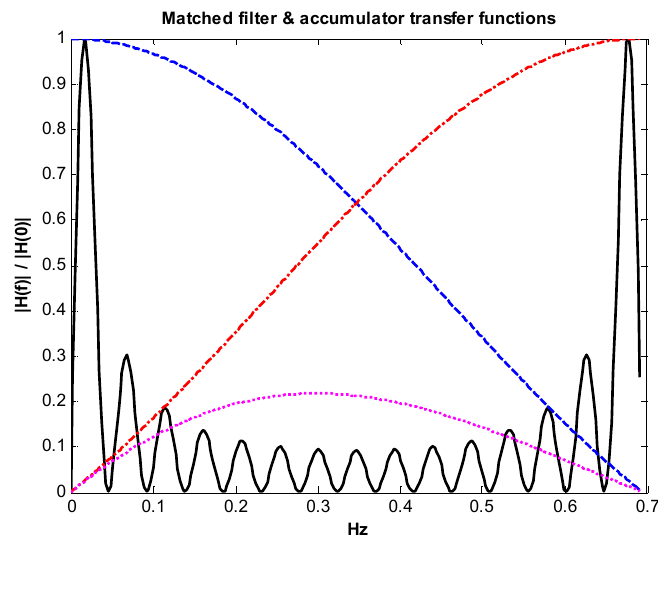
Figure 15. Absolute values of the normalized frequency transfer functions of the matched filter (constant coefficient version) and of the accumulator obtained at 5 km/h velocity. The black solid line corresponds to the matched filter; the blue dashed line is the accumulator fundamental response. The first accumulator aliases resulting from decimation are represented in red dot-dashed curve and magenta dot